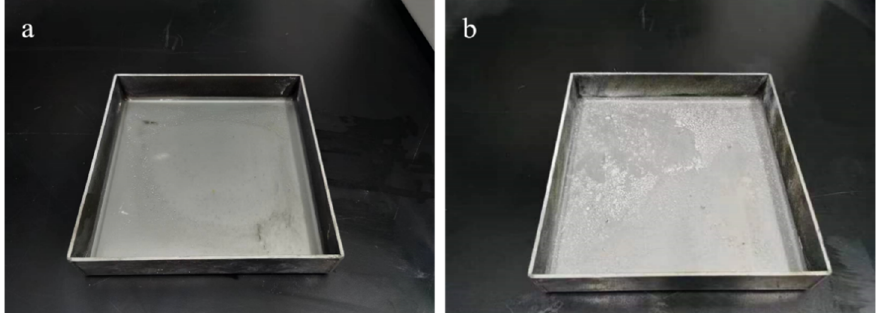
Figure 8. Fire extinguishing agent coverage effect: ( a ) ultrafine NH 4 H 2 PO 4 powder and ( b ) ultrafine struvite powder.